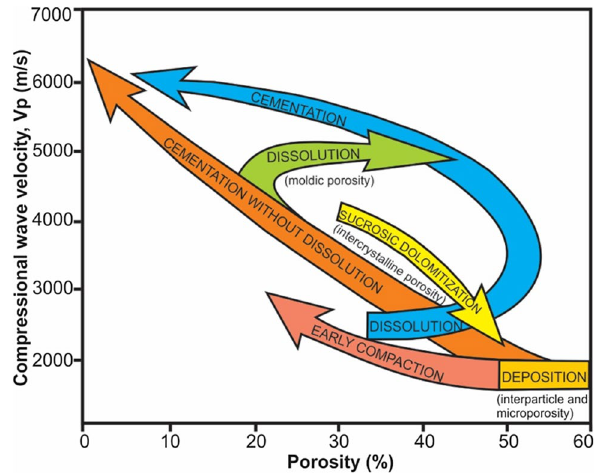
Fig. 14 Velocity-porosity paths of various diagenetic processes in carbonate sediments. Any given process may have a different position on the diagram depending on the timing of the diagenetic events, but the trend (direction of arrow) should be the same (after Anselmetti and Eberli